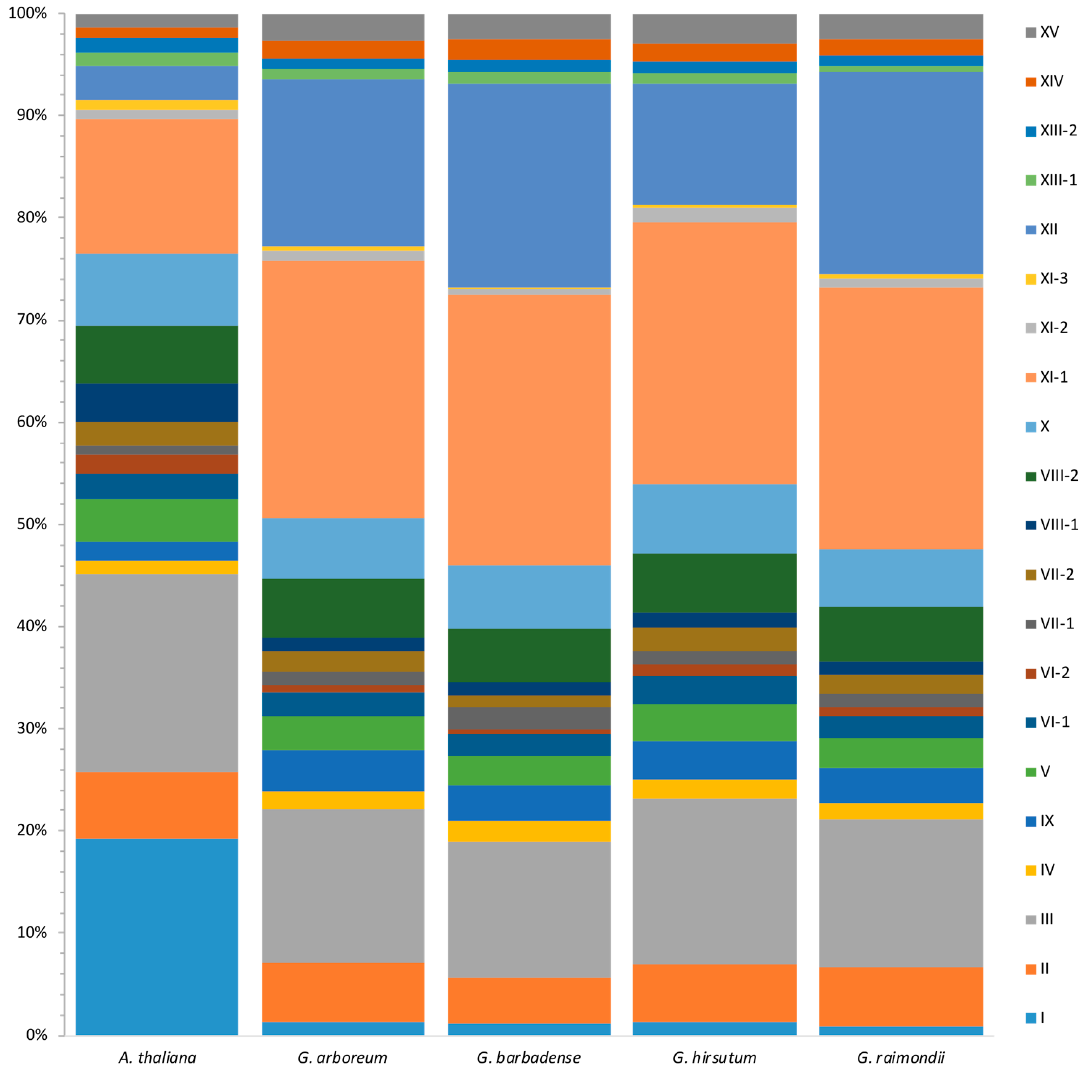
Figure 3. Comparison of LRR-RLK gene distribution among different subfamilies between A. thaliana and Gossypium . For each species, all the LRR-RLKs were divided into 21 subfamilies, represented by rectangles within different colors. The area of each rectangle within a specific color represented the proportion of the corresponding subfamily.